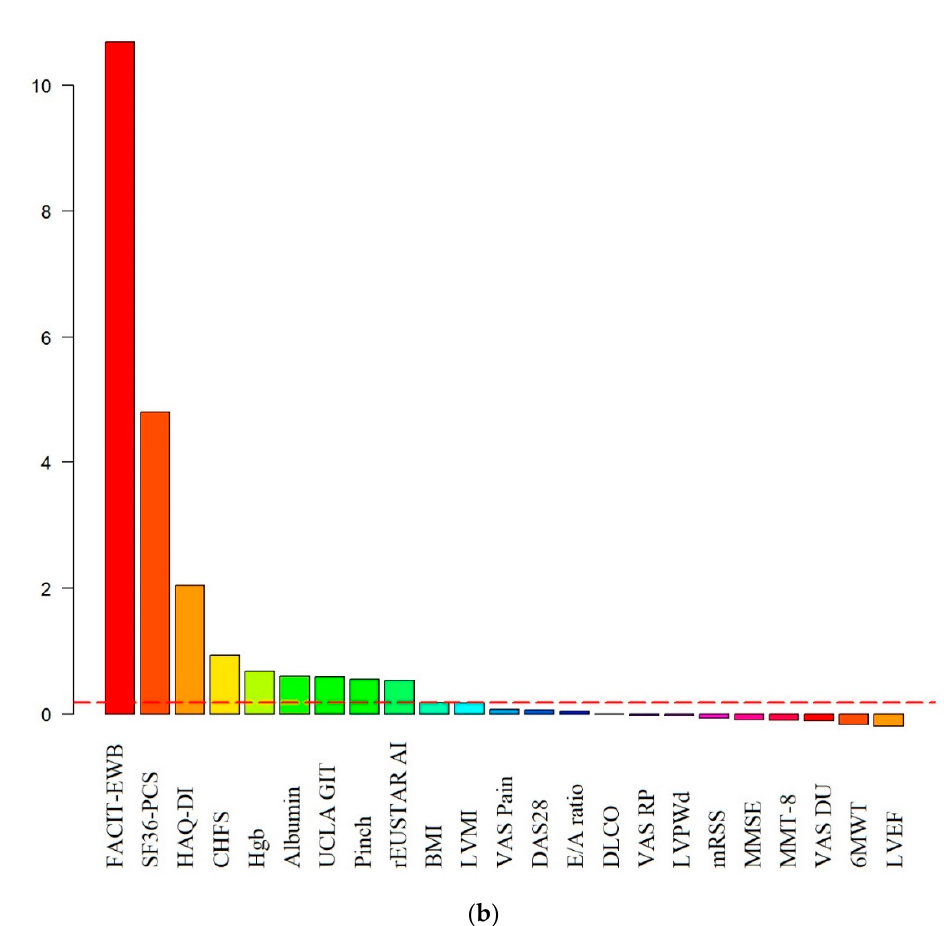
Figure 2. Results of the Random Forest algorithm for the FACIT-FS changes to select the most important factors regarding alterations in levels of fatigue during 12-month follow-up in 144 followed patients with systemic sclerosis. ( a ) Potential predictors among the baseline parameters; ( b ) Influencing factors of the changes of the results FACIT -FS during the follow-up. Y axis represents the relative variable importance (Arbitrary unit). All variables beyond the red dashed line are considered as potential predictors. rEUSTAR AI, revised European Scleroderma Trials and Research Group Activity Index; CHFS, Cochin Hand Function Scale; Duration, Disease Duration Time; HAQ, Health Assessment Questionnaire Disability Index; mRSS, Modified Rodnan Skin Score; ILD, Interstitial Lung Disease; VAS, Visual Analogue Scale; FACIT-EWB, The Functional Assessment of Chronic Illness Therapy Emotional Well-Being; BMI, Body Mass Index; MMSE, Mini Mental State Examination; LVMI, Left Ventricular Mass Index; 6MWT, Six-minute Walk Test; lcSSc, limited cutaneous Systemic sclerosis; dcSSc, diffuse cutaneous Systemic sclerosis; UCLA GIT, University of California, Los Angeles Scleroderma Clinical Trial Consortium Gastrointestinal Tract Instrument 2.0; Hgb, Hemoglobin; RP VAS, VAS for Raynaud’s Phenomena; Pinch, Pinch Strenght; LVEF, Left Ventricular Ejection Fraction; DLCO, Diffusing Capacity for Carbon Monoxide; MMT8; Manual Muscle Testing-8; DU VAS, VAS for Digital Ulcers; DAS28, Disease Activity Score 28; SF36-PCS, Short Form 36 Physical Component Summary; LVPWd, End-Diastolic Left Ventricular Posterior Wall thickness.